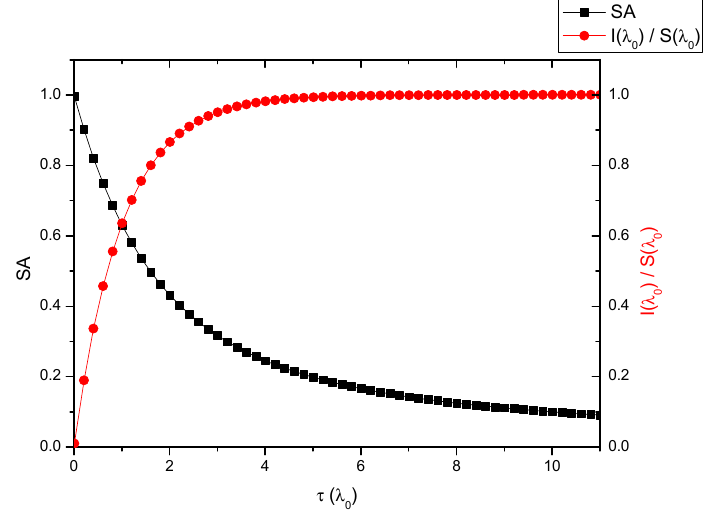
Figure 6. Dependence of SA (black) and normalized line peak intensity (red) on τ ( λ 0 ).